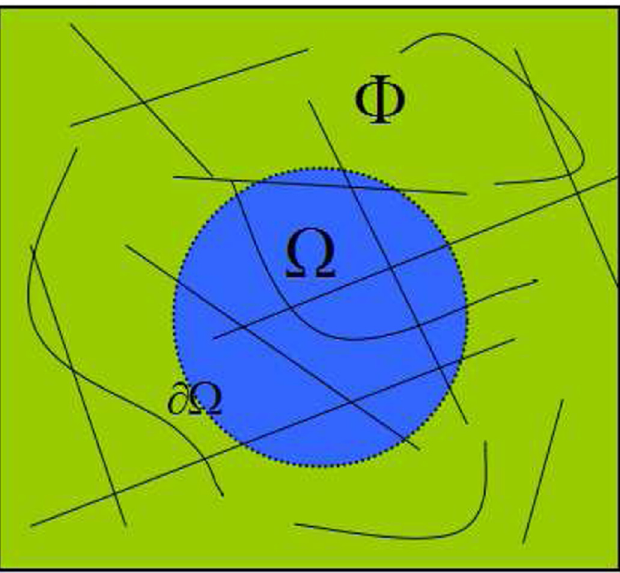
Fig 3. An inpainting image I with structure lines (i.e., black solid lines).